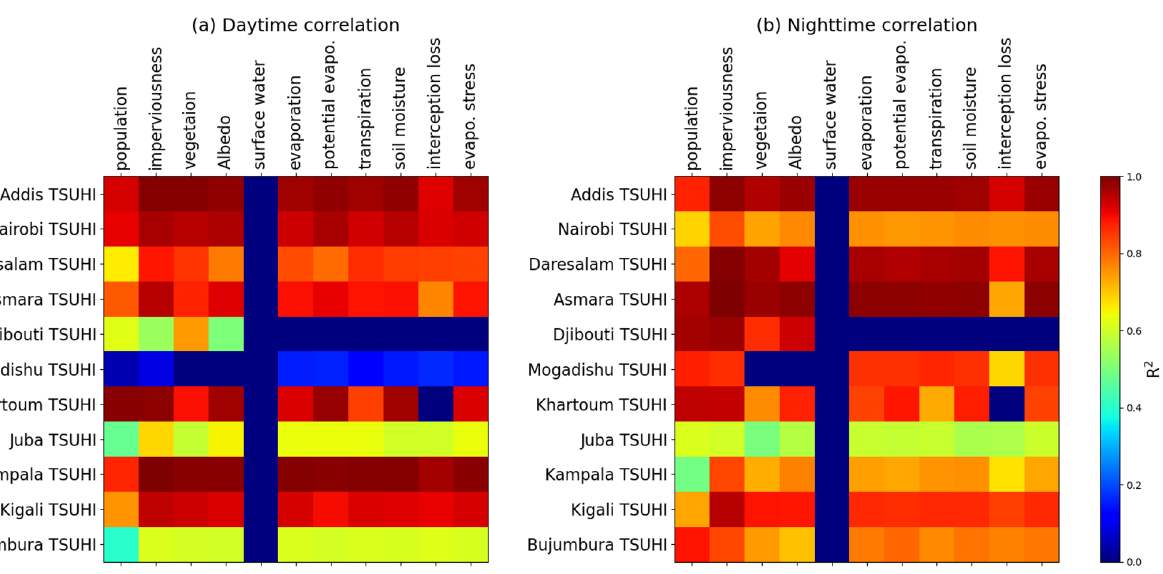
The regional contribution of the tropical surface urban heat islands is to enforce more warming exacerbating the drought impacts. Out of the 12 cities considered in this study, 10/8 have positive contribution to the regional climate during the day/night respectively. The mean regional contribution from these cities to the regional climate ◦ ◦ are 0.64 C/0.34 C during the day/night respectively. The maximum contribution, 4.8 ◦ during the day and 3.9 C from Daresalam during the night. These two cities are well developed where their urban size and surface properties are the main contributors to the regional warming. This additional warming